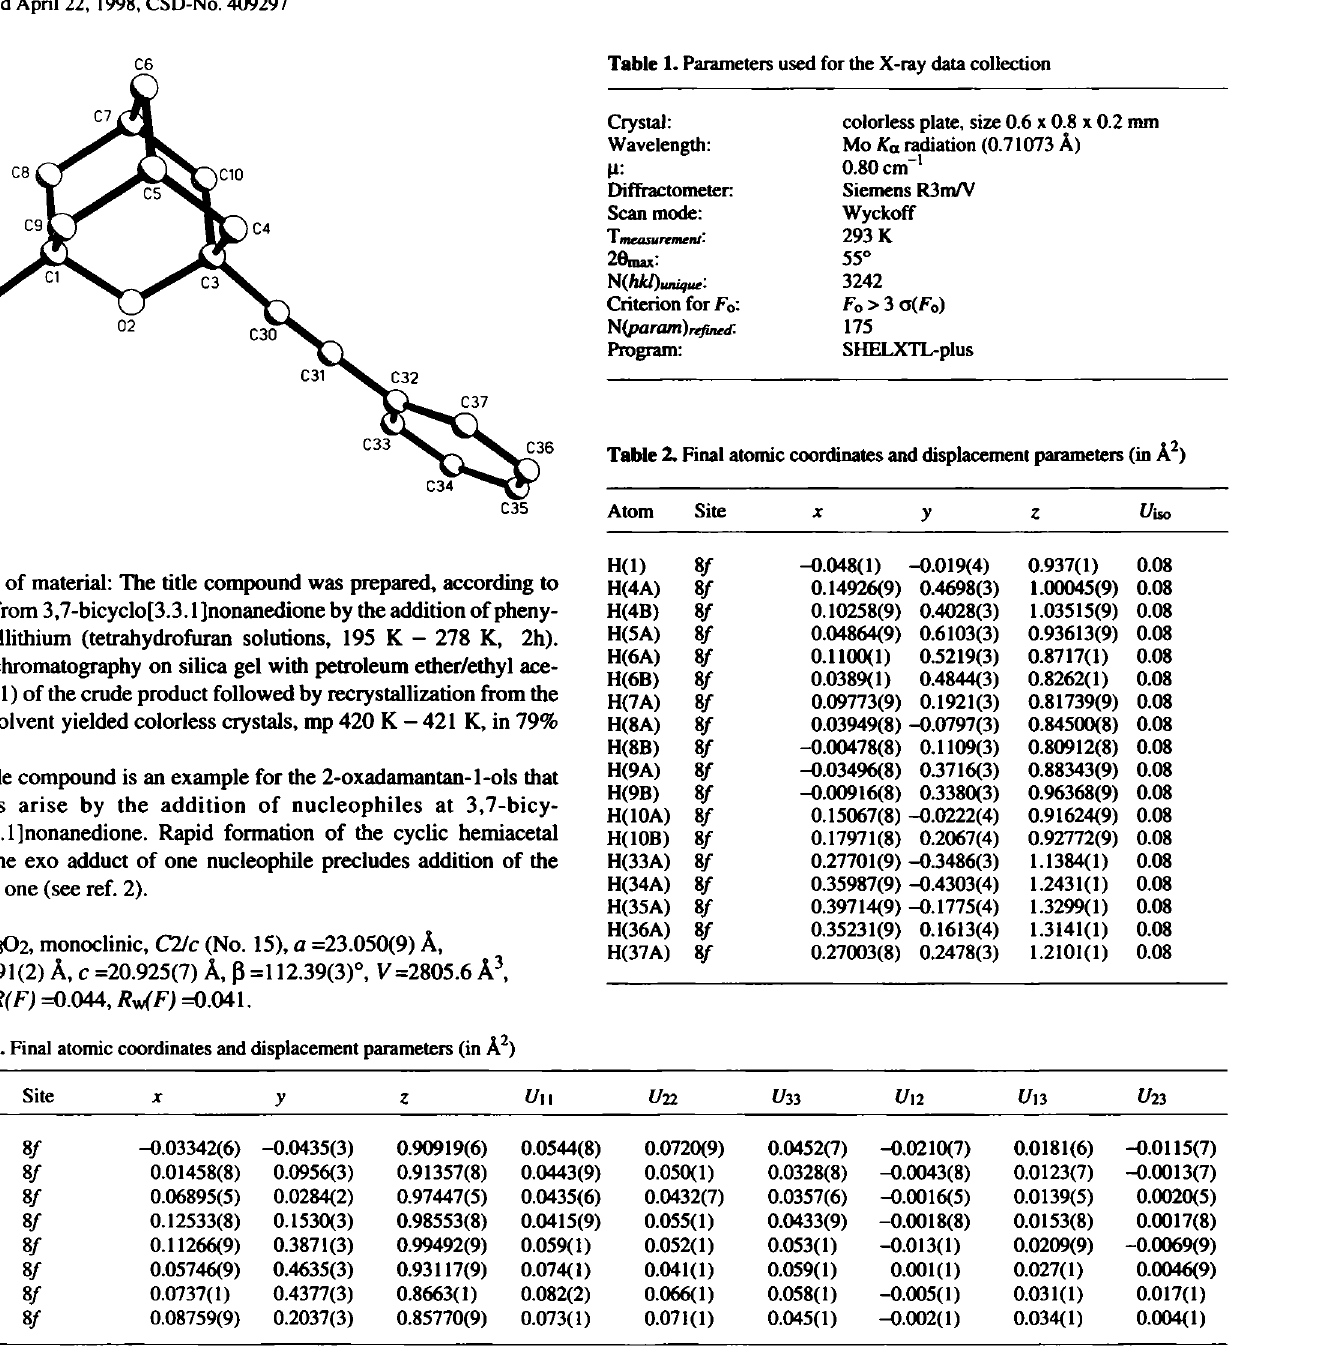
Table 1. Parameters used for the X-ray data collection Crystal: